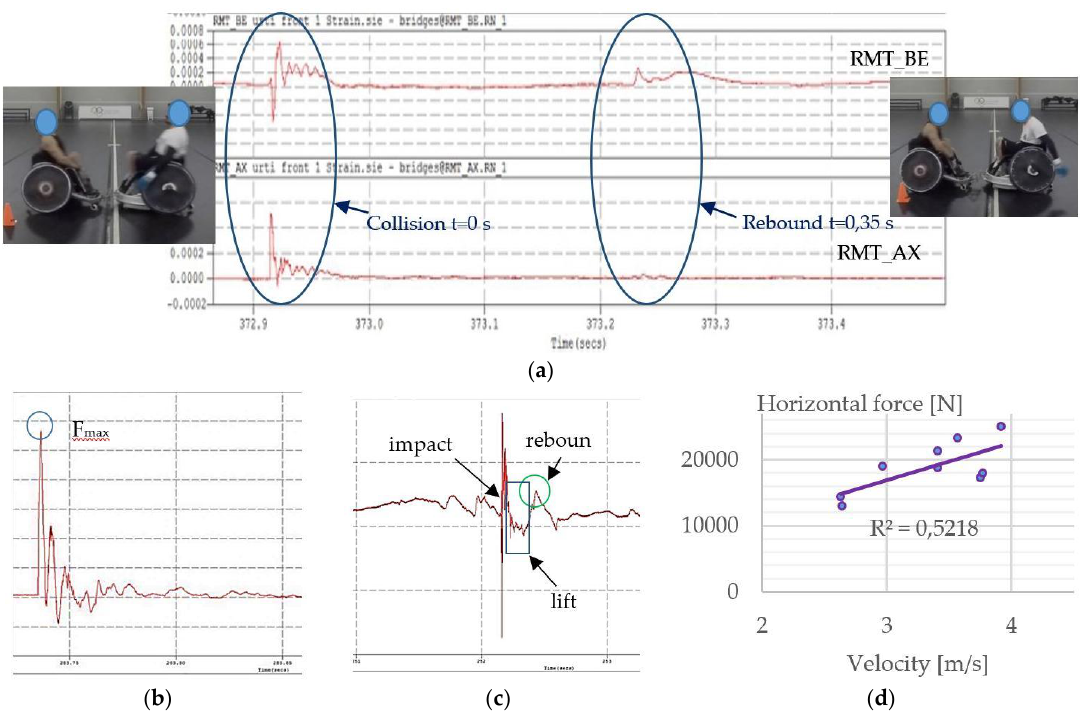
Figure 5. ( a ) Correspondence between video and signal; ( b ) Force trend on RMT_AX bridge during an impact; ( c ) Behaviour of the RMT_BE bridge; ( d ) Maximum Horizontal force/Relative velocity. The values of the impact force and the vertical force applied during the rebound were